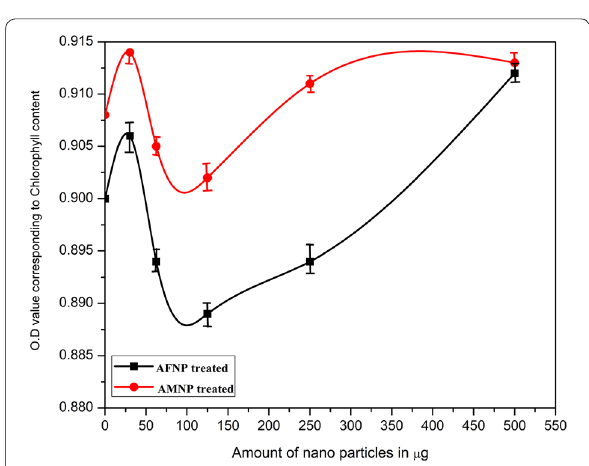
Fig. 7 Chlorophyll content curve with respect to the amount of AFNP and